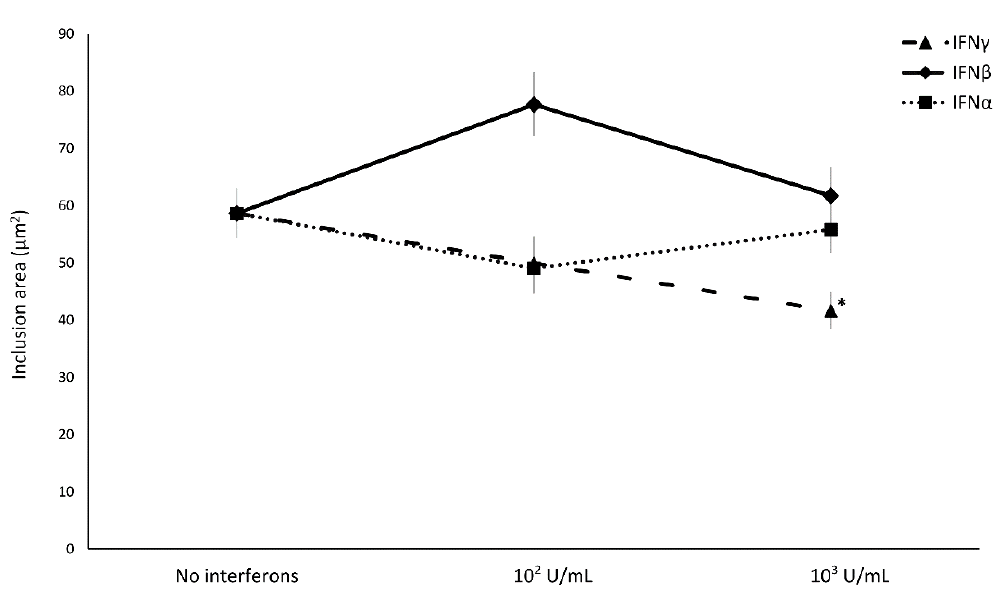
Figure 3. E ff ect of IFN α , IFN β , and IFN γ on C. trachomatis inclusion size in human synovial fibroblasts. Confluent monolayers were infected with C. trachomatis and, then, treated with the IFNs (10 2 or 10 3 IU / mL) for 24 h. The chlamydial inclusion area, expressed as µ m 2 , was measured by fluorescence microscopy at 400 × magnification. * p < 0.01 vs. untreated cells.